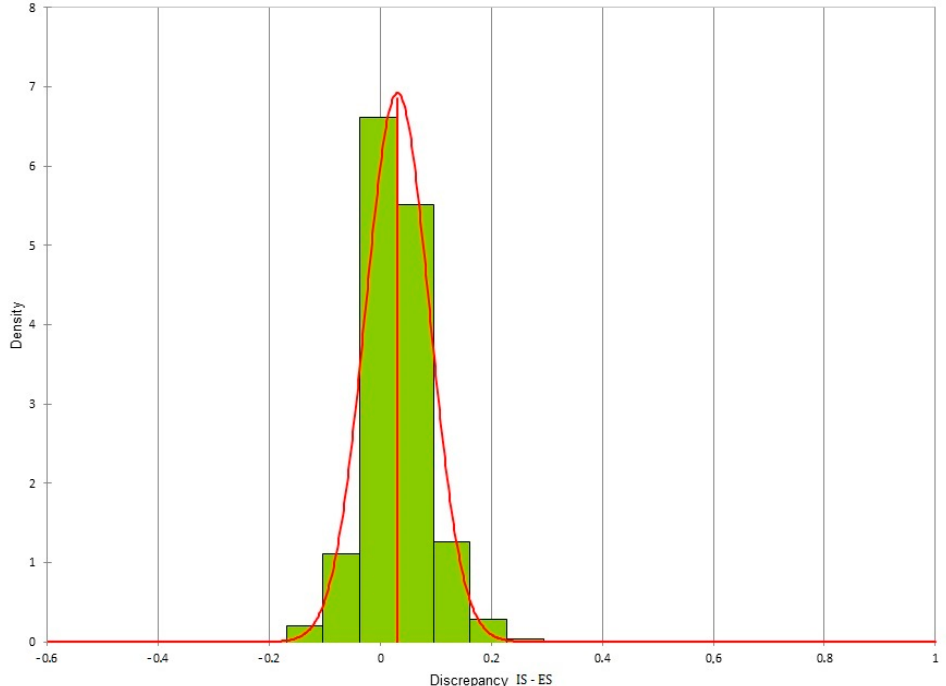
Figure 13. Histogram of the discrepancy between dental extraoral laboratory scanner and intraoral scanner.